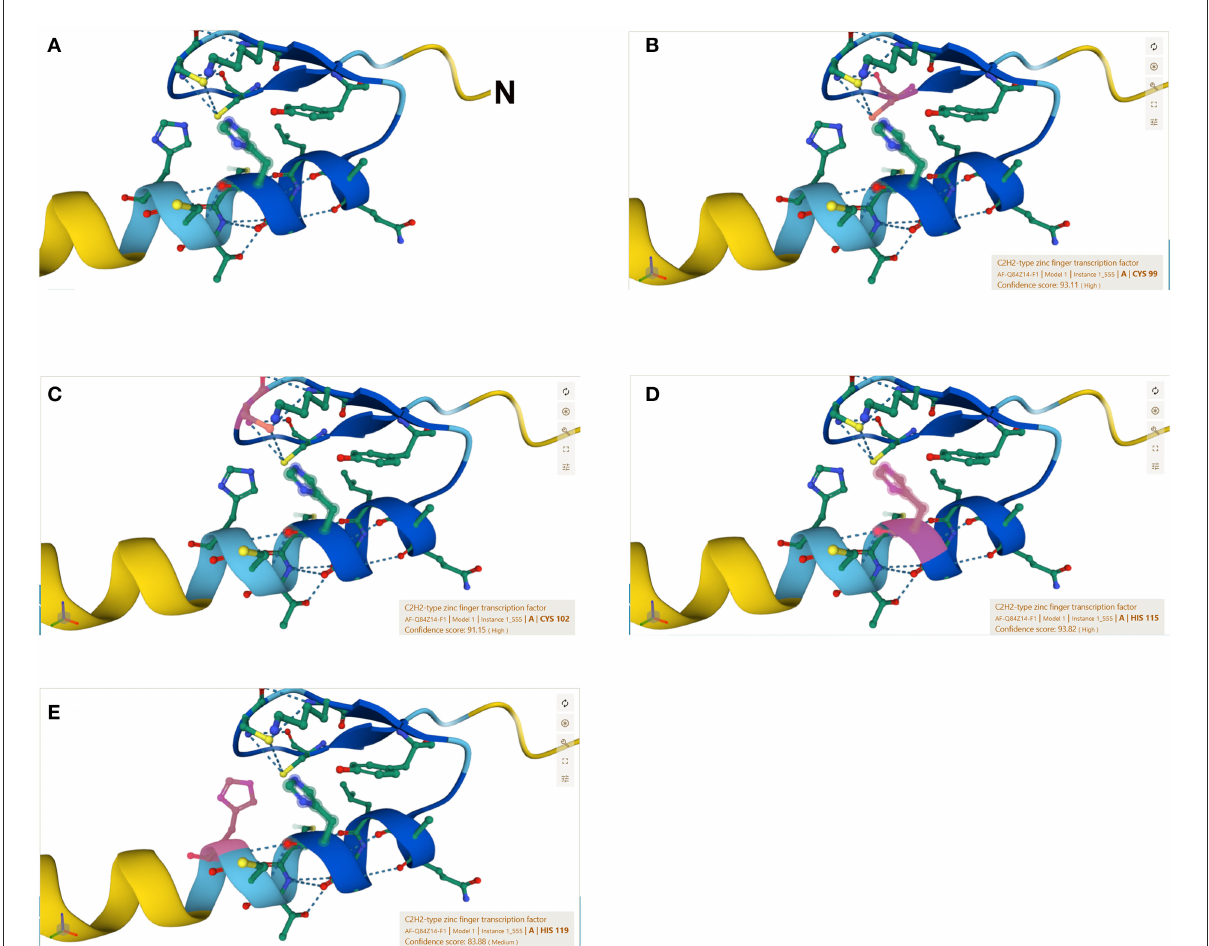
FIGURE2 The ββα amino acid sequence of the ZFP39. (A) Particle ZFP39 sequence forming the ββα structure: N terminal-PSQRAYECSVCGKVYWCY QALGGHMTCHRNLFAQ-C terminal. See Figure 1A for the full amino acid sequence. (B) Pink color showing the 99th amino acid cysteine of the ZFP39. (C) Pink color showing the 102th amino acid cysteine of the ZFP39. (D) Pink color showing the 115th amino acid histidine of the ZFP39. (E) Pink color showing the 119th amino acid histidine of the ZFP39. The zinc is tetrahedrally coordinated between two cysteines at the β -sheet and two histidines at the α